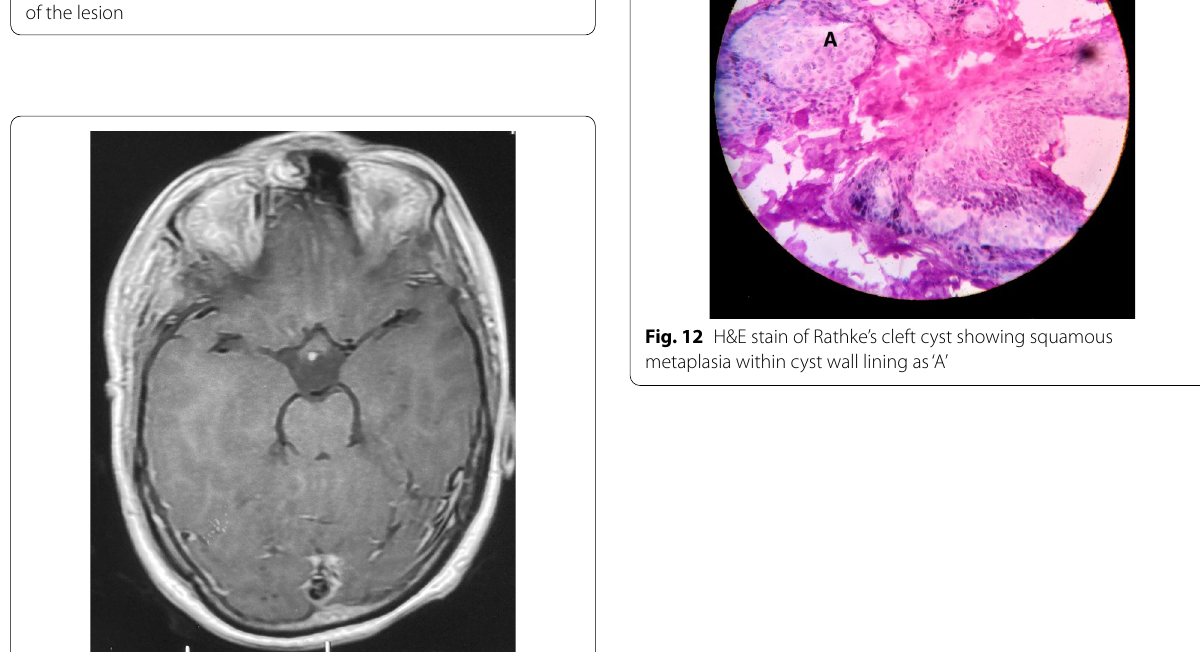
Fig. 9 Post-operative MRI sagittal section showing complete removal